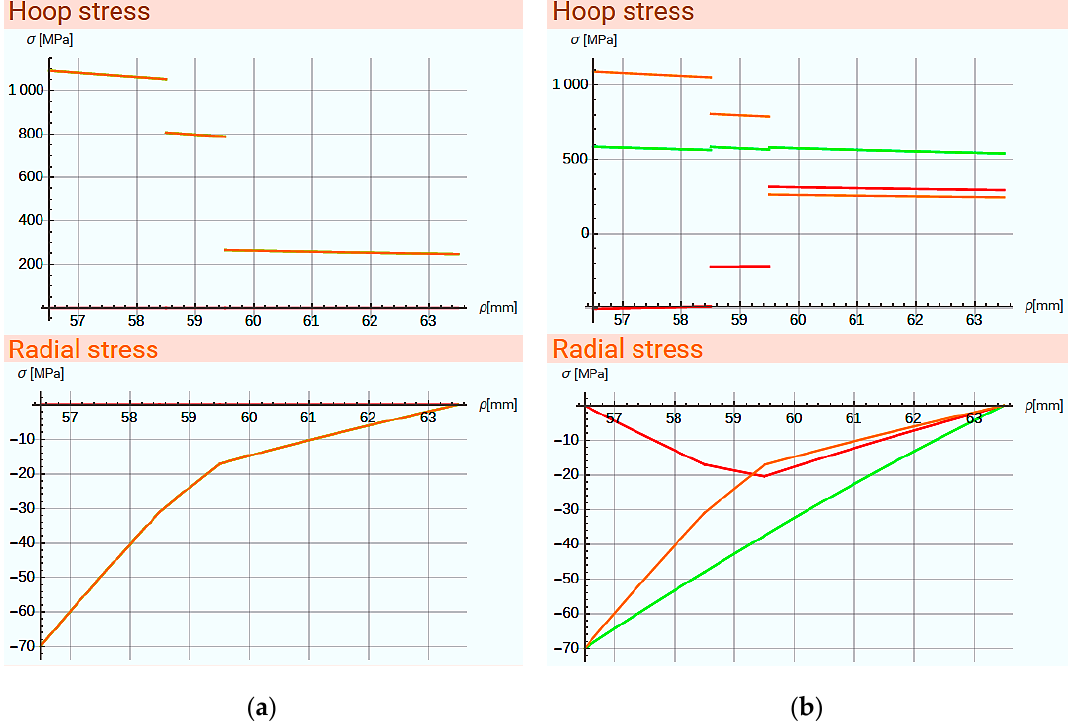
Figure 26. Dialogue window of calculation results. The colour of the graphs represents: ― stresses due to internal pressure, ― stresses resulting from the introduction of fibre tension, ― stresses after optimization.